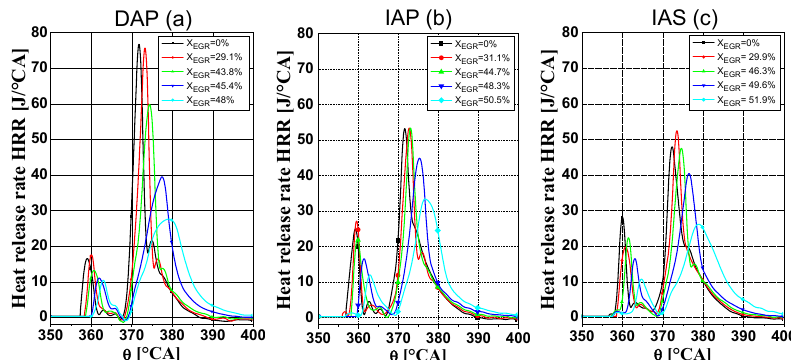
Figure 6. Comparison of the HRR traces featuring different EGR rates, at 1500 × 2, for the three injector typologies under investigation: ( a ) DAP; ( b ) IAP; ( c ) IAS.